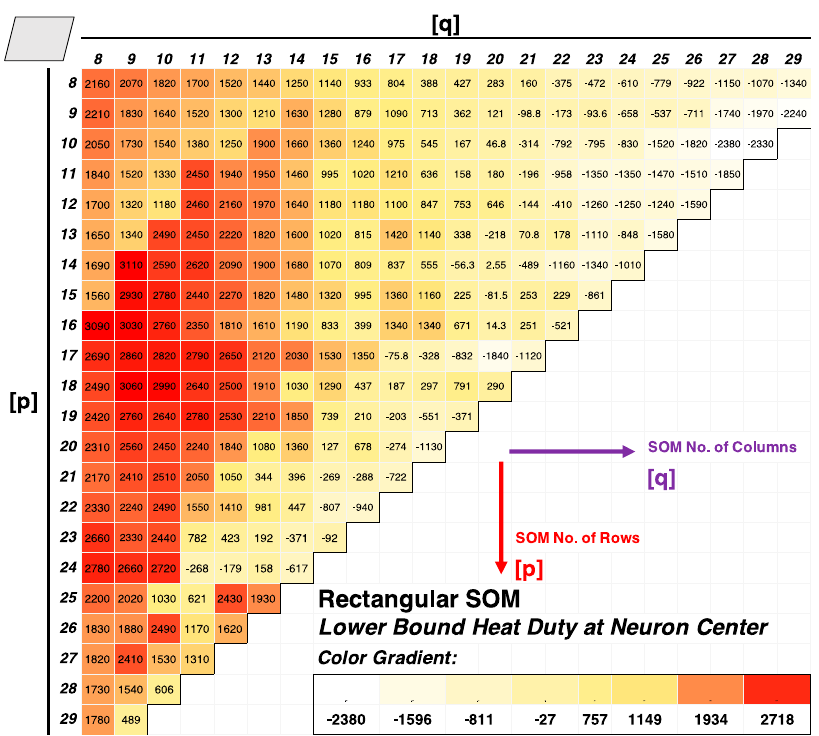
Figure 5. Lowest nominal value of the model variable ‘heat duty’ in a trained rectangular SOM in hexagonal lattice at number of rows and number of columns of the SOM lattice.